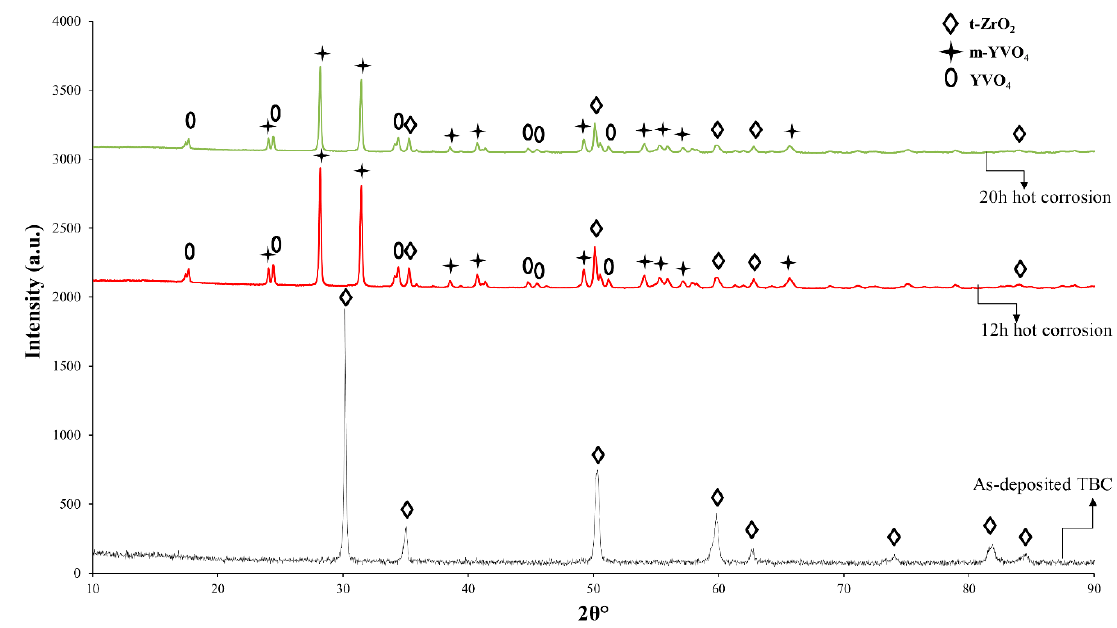
Figure 7. XRD analysis of TBC before and after hot corrosion tests.